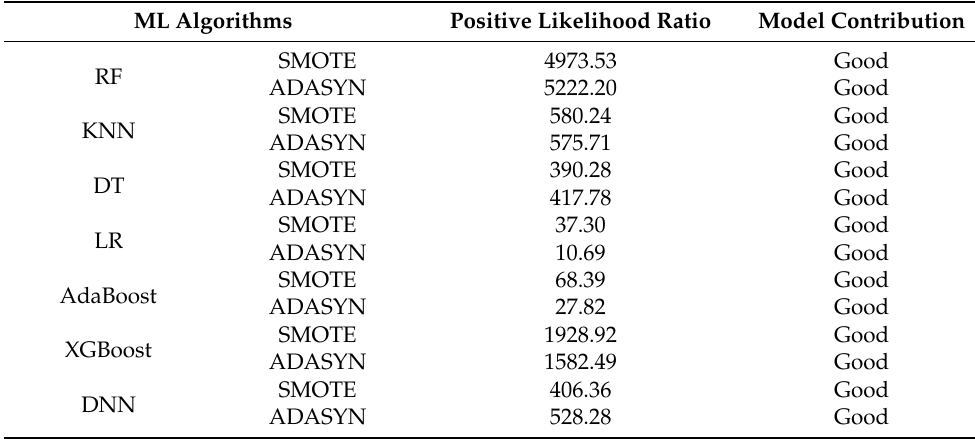
Table 12. Positive Likelihood Ratio based on resampling approach 2.